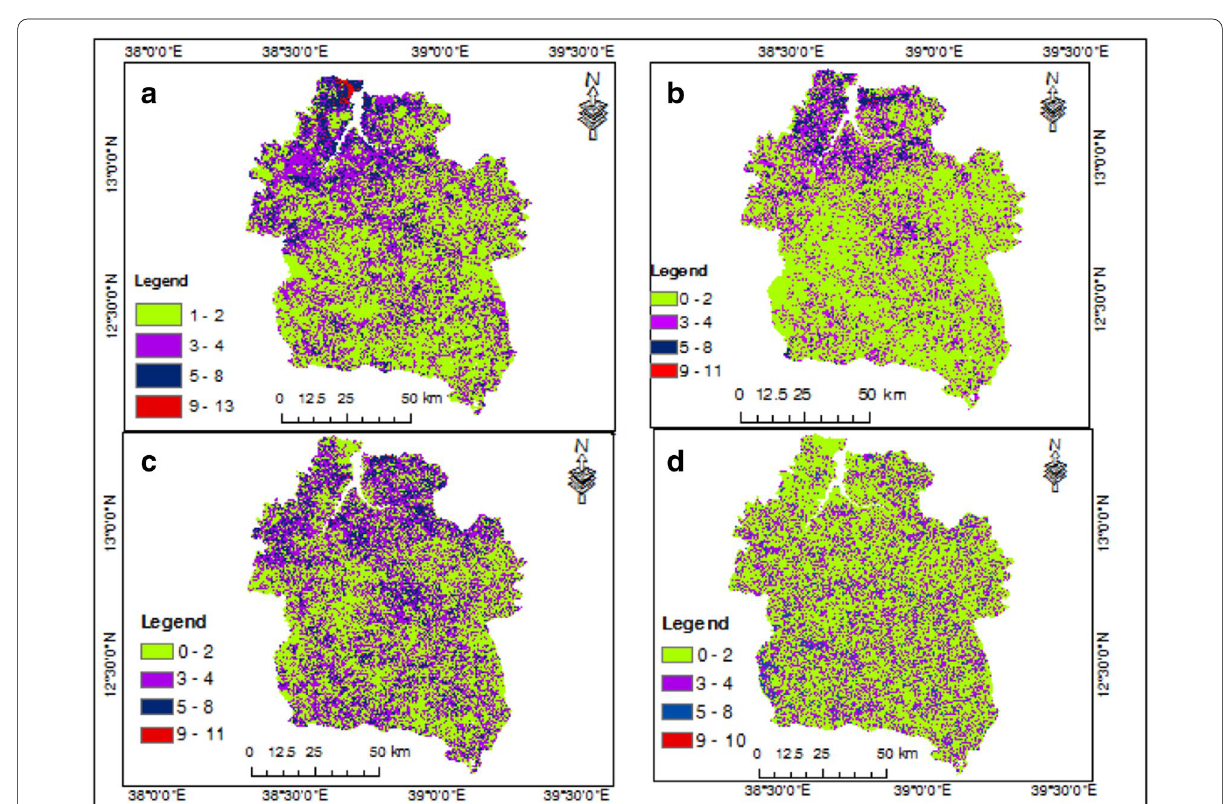
Fig. 15 Frequency of Agricultural drought risk in four different severity classes: a very severe, b severe, c moderate and d